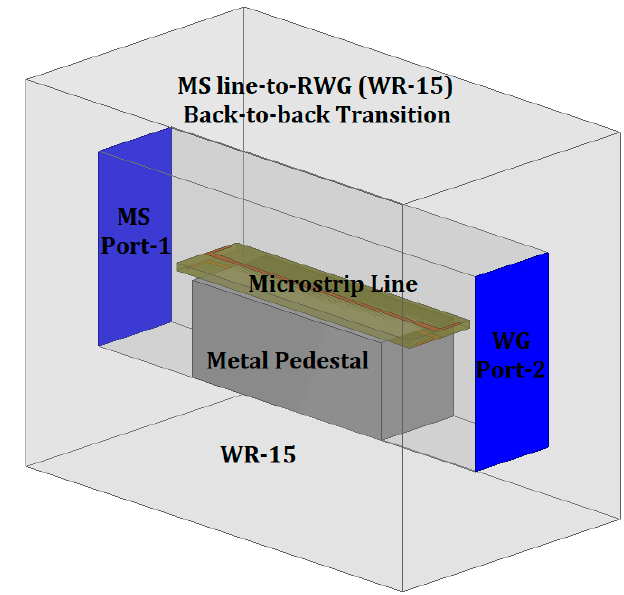
9 of 17 Figure 5. Effect of variations of dipole antenna length on RL and IL plots. 3. Results A back-to-back transition for the MS line to the waveguide for the V-band is shown in Figure 6. The RL and IL plots of conventional and back-to-back (B2B) MS line-to-RWG transitions at the V-band are represented in Figure 7 and compared in Table 5. It is concluded from the comparison of the plot results that the conventional MS-to-WG transition has IL close to − 0.1 dB that guarantees maximum transmission at 60 GHz and excellent impedance matching over − 10 dB FBW (55.57–65.76 GHz). On the other hand,